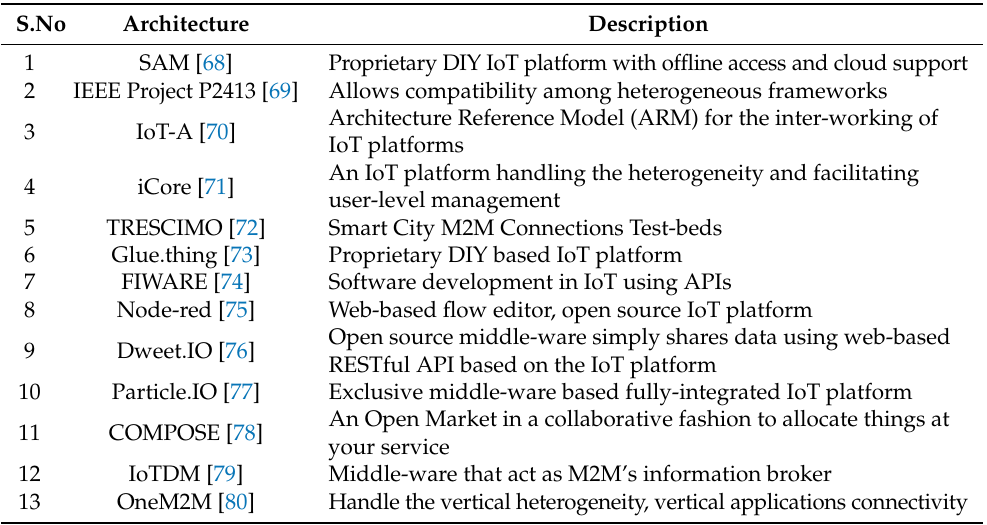
Table 2. IoT architecture